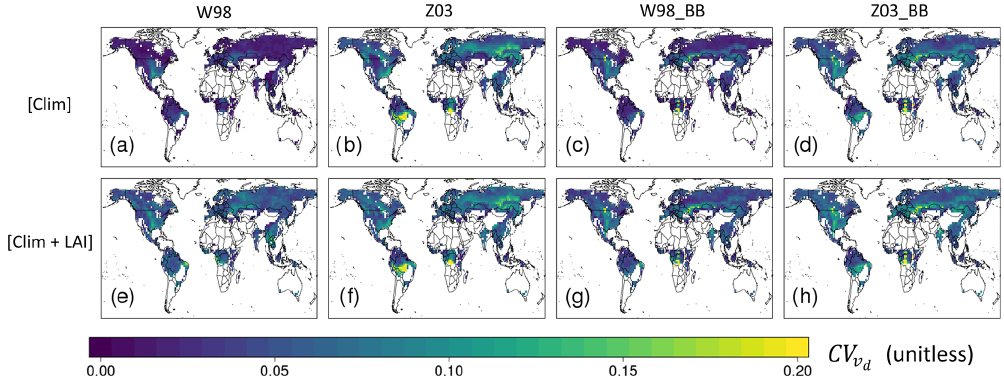
Figure 10. Interannual coefficient of variation of linearly detrended July mean daytime v d (CV v surface.